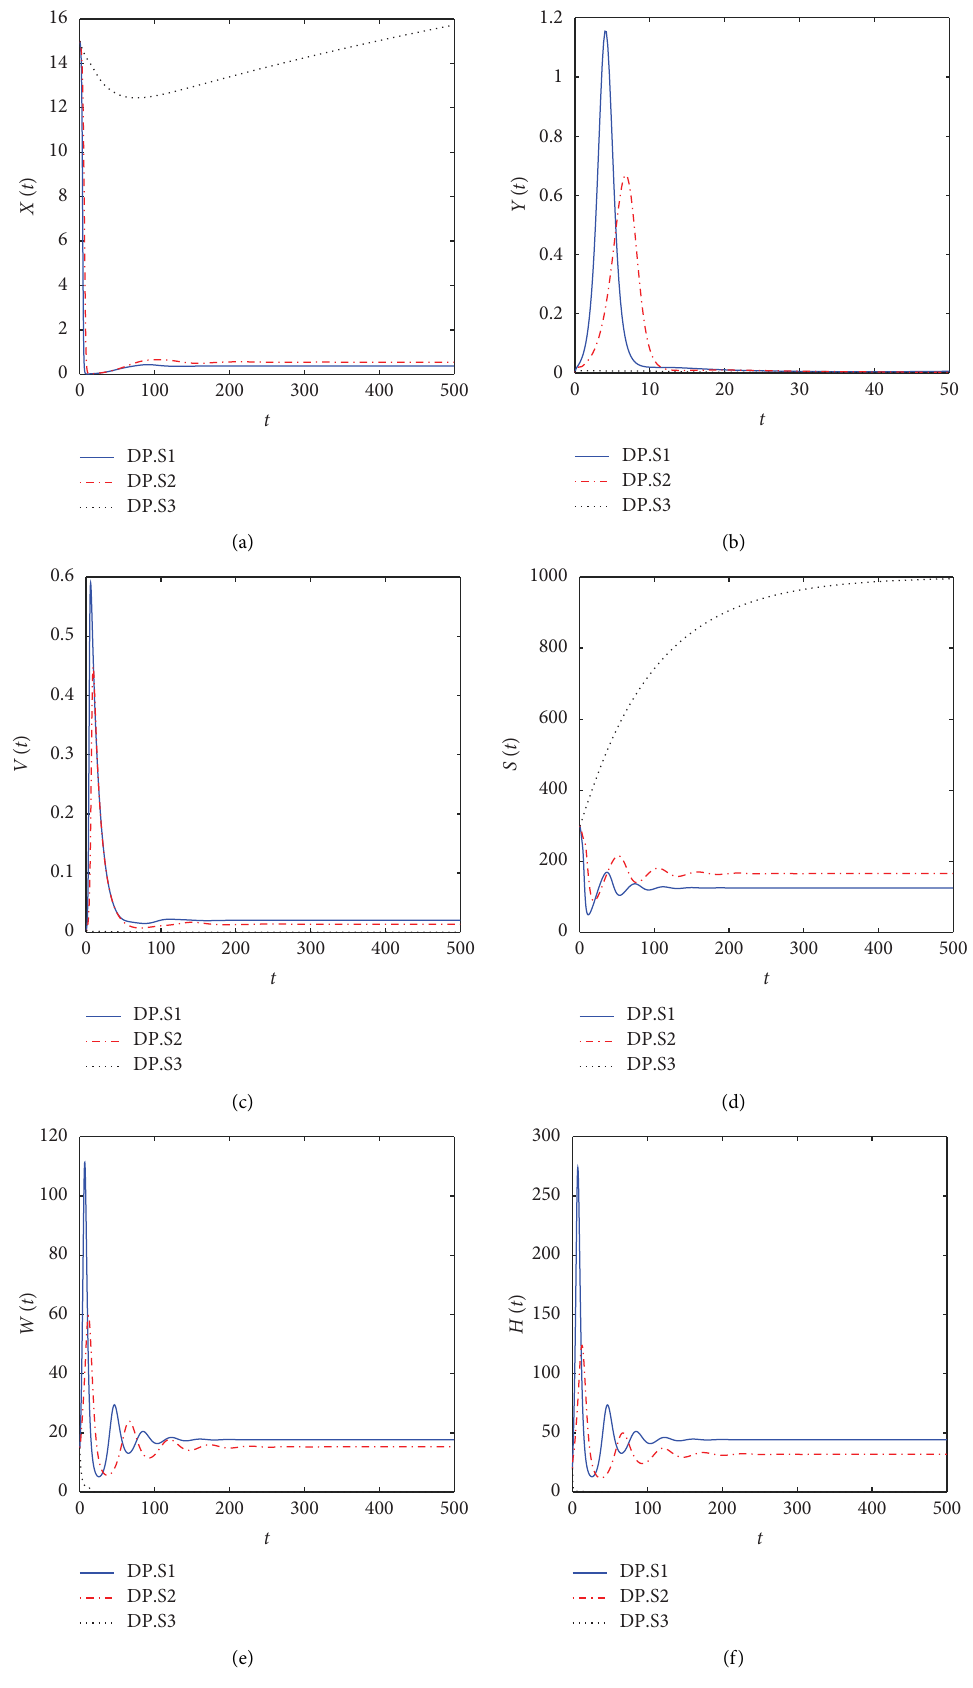
Figure 6: Model (64) numerical simulations for η � 2 . 9, υ � 0 . 02, ℘ � 0 . 1, and I � 0 . 0016 with three diferent sets of delay parameters. (a) Uninfected epithelial cells. (b) Infected epithelial cells. (c) SARS-CoV-2. (d) Uninfected CD4 + T cells. (e) Infected CD4 + T cells. (f)